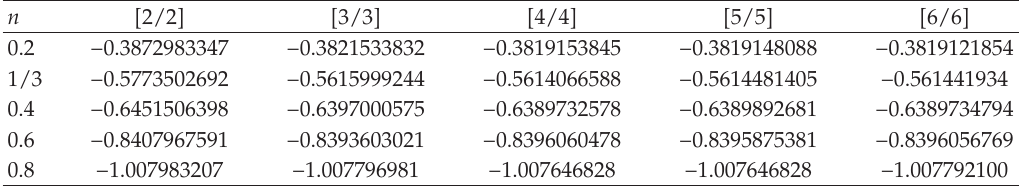
Table 2: Numerical values for α (cid:9) f (cid:6)(cid:6) (cid:3) 0 (cid:4) for 0 < n < 1 by using diagonal Pad´e approximants (cid:6) 51 (cid:7) .